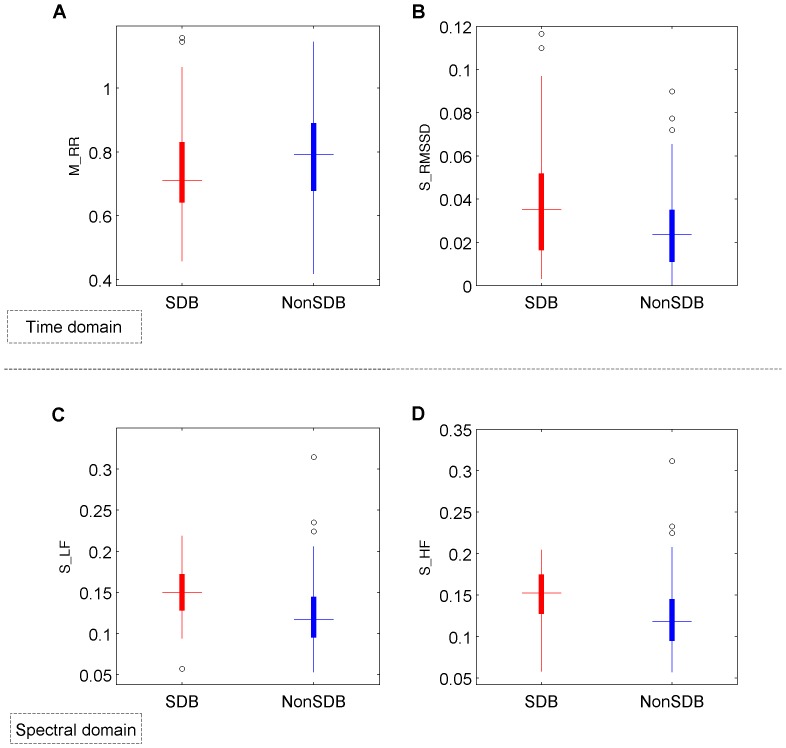
Distribution of PRV features.Boxplot of features extracted from PRV analysis such as (A) the mean of pulse to pulse intervals (M_RR), (B) the standard deviation of RMSSD (S_RMSSD) in time domain, (C) the standard deviation of the normalized power in the LF, and (D) HF band in the spectral domain (S_LF and S_HF, respectively). Children with SDB reflect higher heart rate and PRV dispersion, reflected by a lower pulse to pulse interval and higher standard deviation of the standard PRV measures. Quartile values are displayed as bottom, middle and top horizontal lines of the boxes. Whiskers are used to represent the most extreme values within 1.5 times the interquartile range from the median. Outliers (data with values beyond the ends of the whiskers) are displayed as circles.